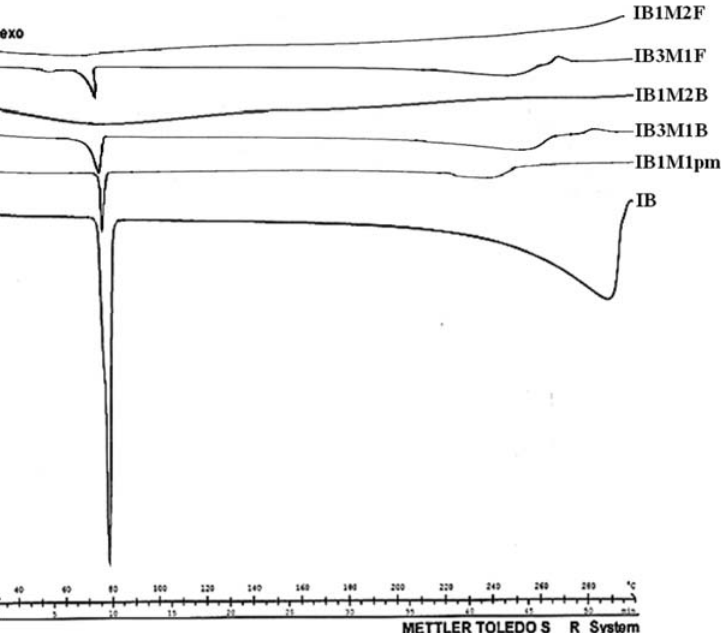
Figure 3. Differential scanning calorimetry of co-processed ibuprofen and magnesium trisilicate after dry-state ball-milling, and aqueous state equilibration and freeze-drying (abbreviations are explained in Table